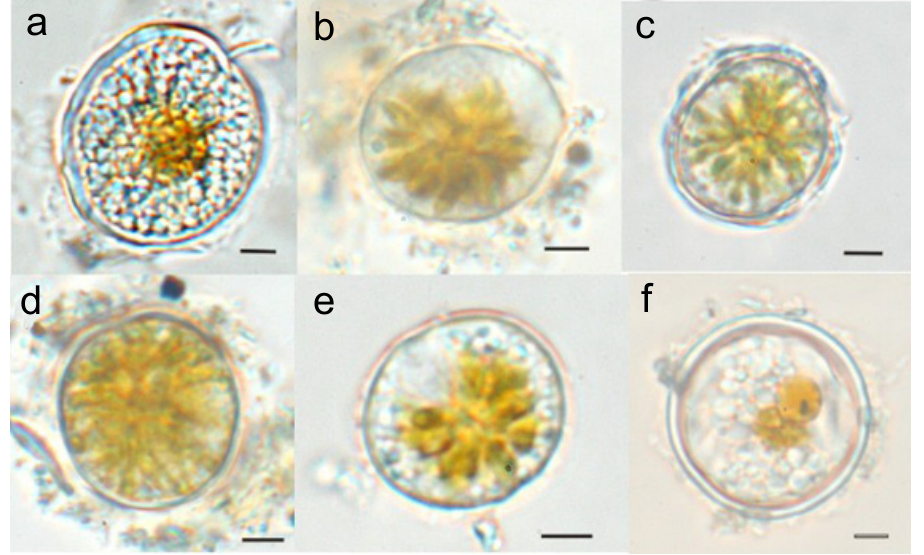
Figure 3. Resting cysts and pellicle cysts of Alexandrium minutum . Resting cyst from a sediment trap ( a ), pellicle cyst with only a thin pellicle layer ( b ), pellicle cyst with the theca of the vegetative cell remaining ( c ), pellicle cyst with uncondensed cytoplasm ( d ), pellicle cyst with condensed cytoplasm ( e ), and double-walled resting cyst from the sediment ( f ). Scale bar: 10 µm. Adapted from